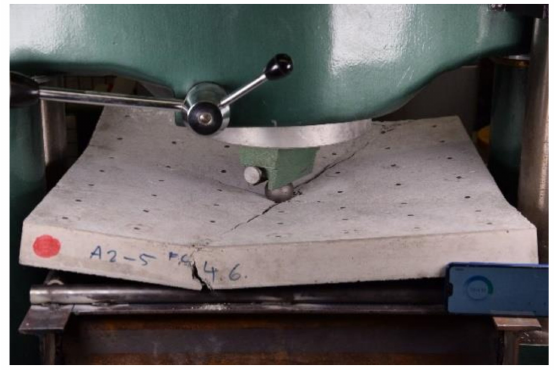
Figure 15. Specimen A2_5 loaded in a laboratory.